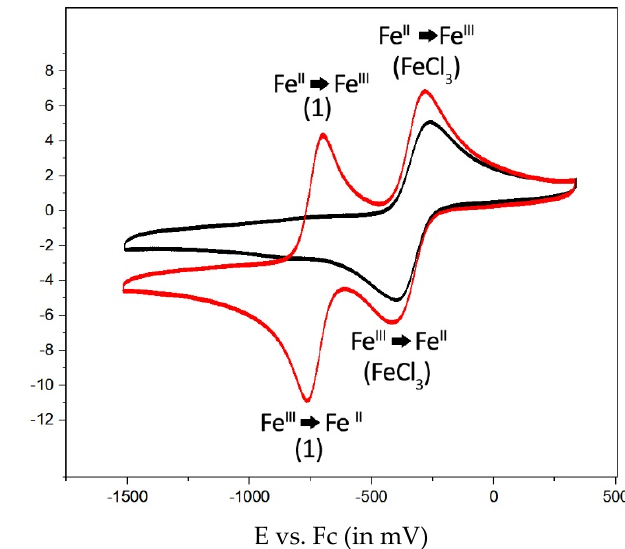
Figure 10. Voltammogram of FeCl 3 (1 mM) as black trace and FeCl 3 (1 mM) and combined with 1 (1 mM) as red trace in DMSO vs. Fc (2 mM).